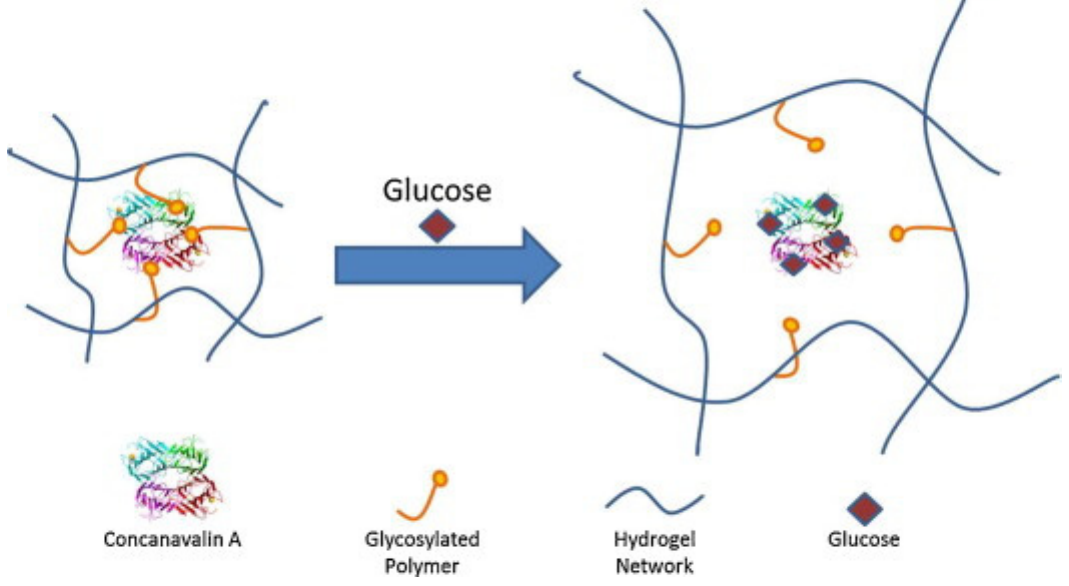
Figure 9. Illustration of hydrogel network swelling for insulin release via ConA’s affinity for glucose. Adapted with permission from [58]; Published by Elsevier,